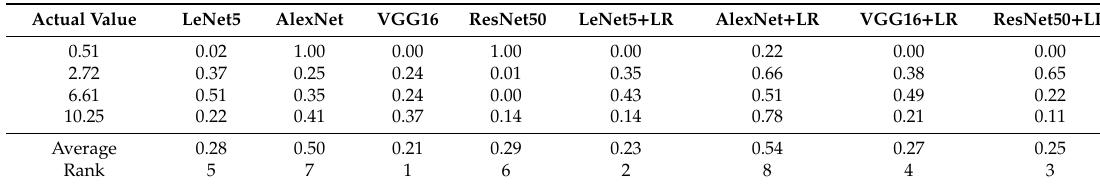
Table 5. Mean absolute percentage error